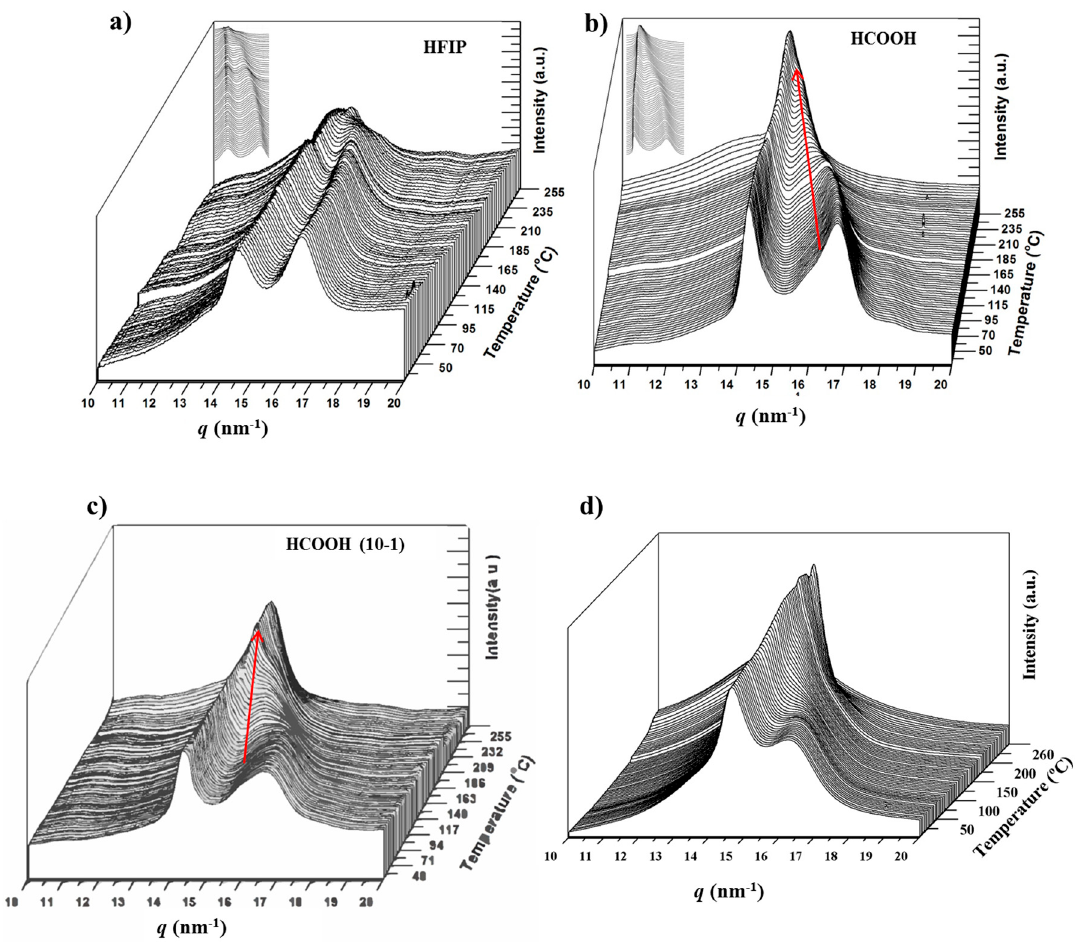
Figure 13. Three dimensional representation of WAXD profiles of nylon 4 9 during heating (10 ◦ C/min) from room temperature to fusion for: ( a ) solvent casting film from HFIP at a polymer concentration of 2 mg/mL; ( b ) solvent casting film from formic acid at a polymer concentration of 2 mg/mL; ( c ) solvent casting film from formic acid at a polymer concentration of 10 mg/mL; and ( d ) melt quenched sample.